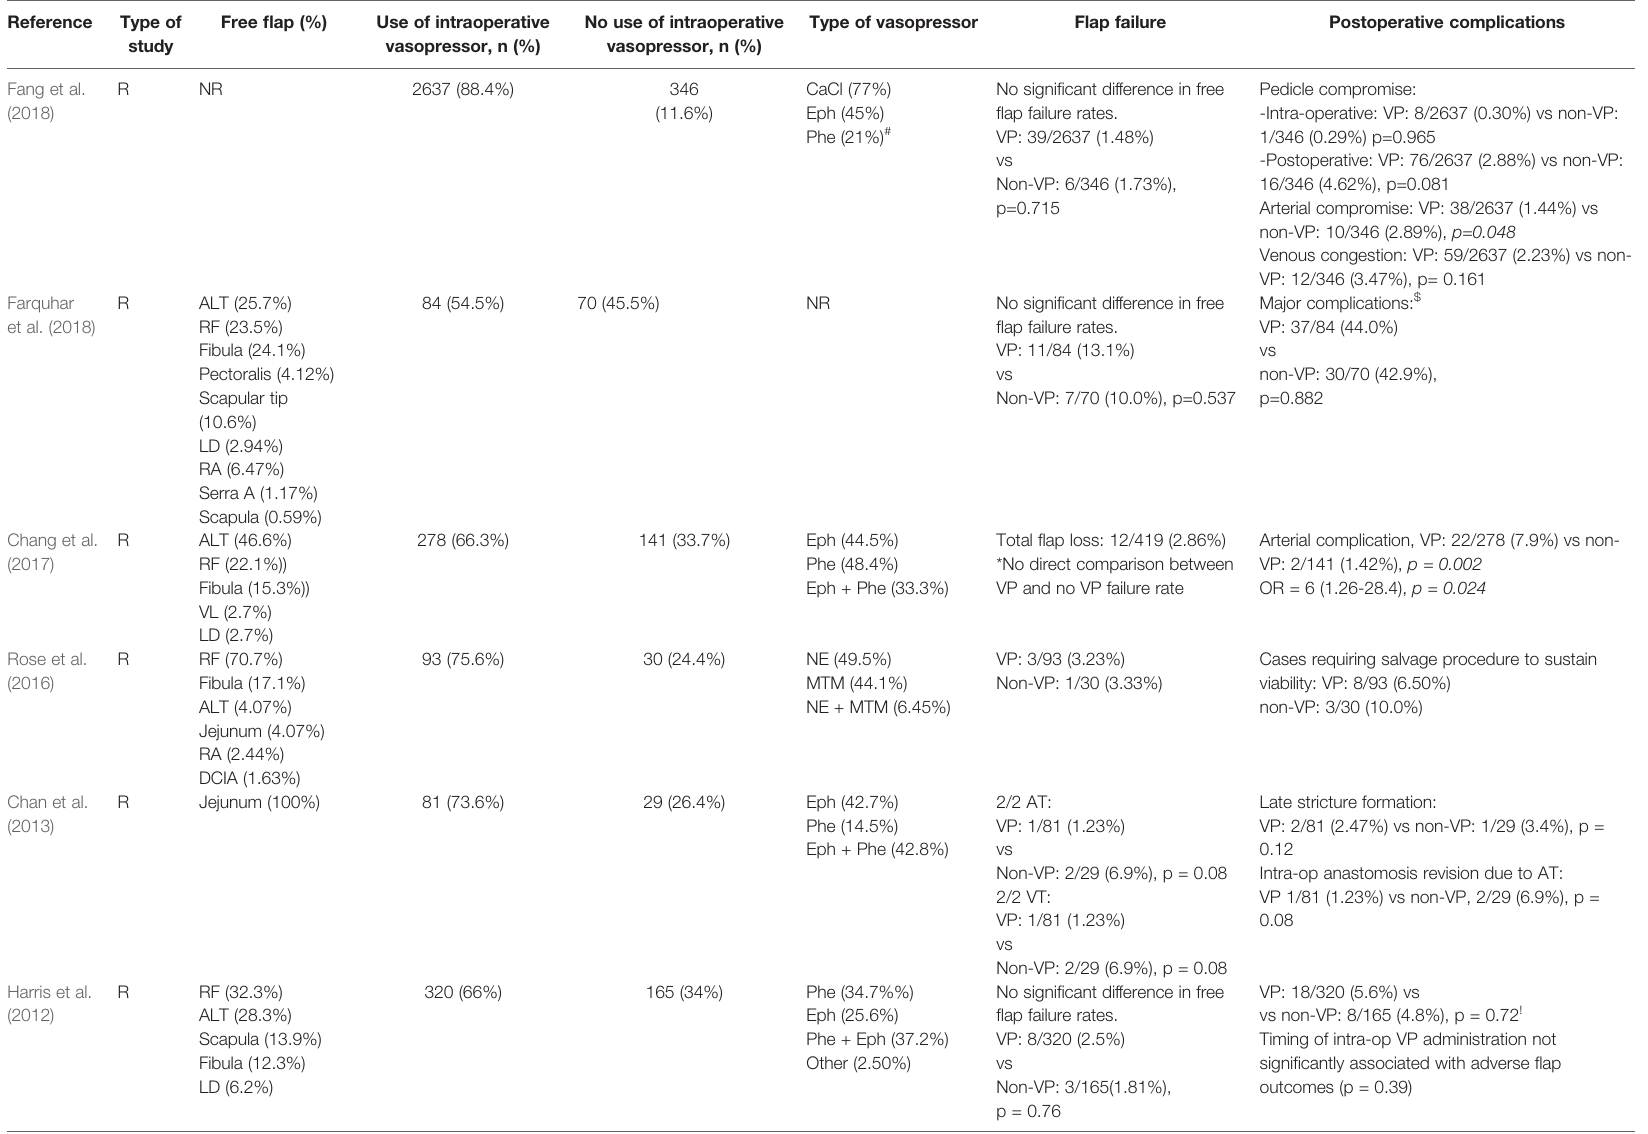
TABLE 1 | Flap Outcomes and Postoperative Complications Among Studies Examining the Effect of Intraoperative Vasopressors in Head and Neck